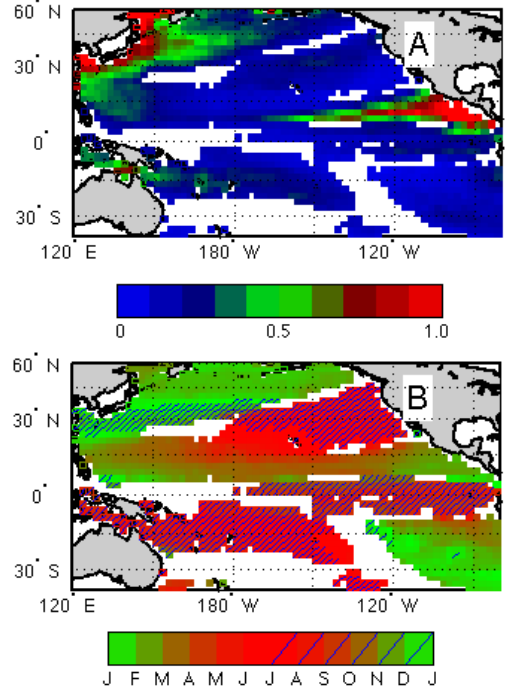
Fig. 10. (a) Amplitude and (b) phase of the seasonal cycle of S 0 ( E-P ) from Eq. (2). White or blank areas indicate that enough h data existed, but no significant seasonal cycle was found. Color scale for panel (a) is shown with units of 10 − 7 pss. Color scale for panel (b) is shown. Units are months indicating maximum value of S 0 ( E-P ) h